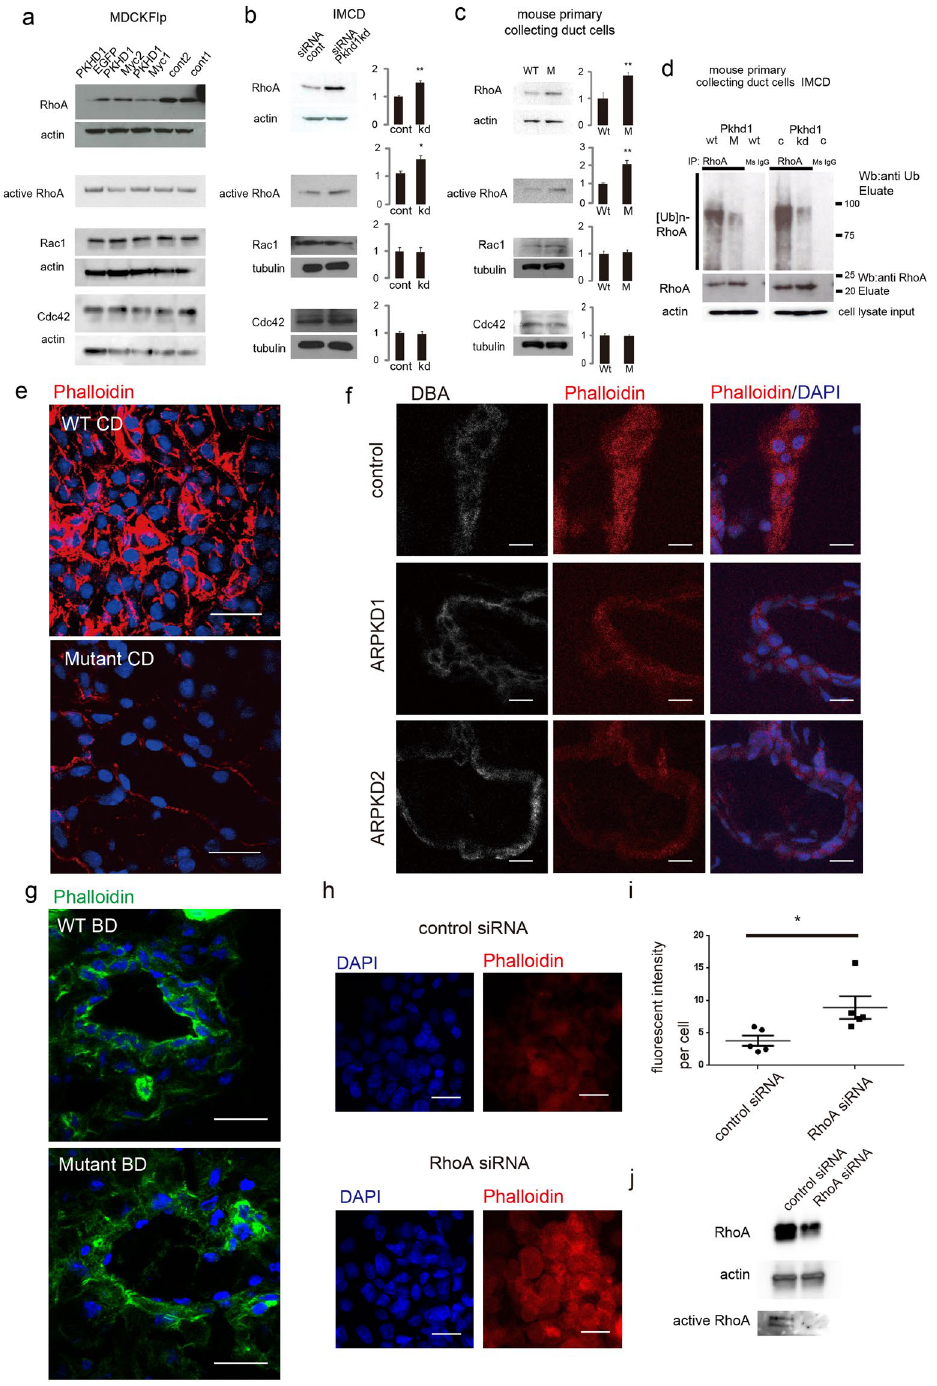
Figure 1. Fibrocystin/Polyductin (FPC) regulates RhoA levels and function. ( a ) Immunoblots of total cell lysates of multiple independently-derived PKHD1 -expressing and pcDNA5 vector control (cont) Flp-In MDCK cell lines probed for RhoA, active RhoA, Rac1 and Cdc42. The blots were stripped and re-probed for actin as a loading control (except the active RhoA blot). ( b ) On the left are immunoblots of cell lysates from IMCD cell lines stably expressing siRNA targeting either Pkhd1 (kd) or a random sequence (cont). The bar graphs on the right provide the quantitative analysis of three independent experiments. The level of expression of each Rho GTPase was determined relative to that of actin or tubulin, and the values for the control cell line was arbitrarily set at one. For the active RhoA blot, equal amounts of cell lysate were loaded. Values represent mean ± s.d. ** P < 0.01. ( c ) Same as in panel “b” except primary cultures of collecting duct cells isolated from wild type controls (WT) or Pkhd1 del3-4/del3-4 (M) were the source material. Values represent the mean ± s.d. of three experiments, ** P < 0.01. ( d ) RhoA was immunoprecipitated from cell lysates of primary cultures of wild type (WT) and Pkhd1 del3-4/del3-4 (M) collecting duct cells and control (C) and Pkhd1 -silenced